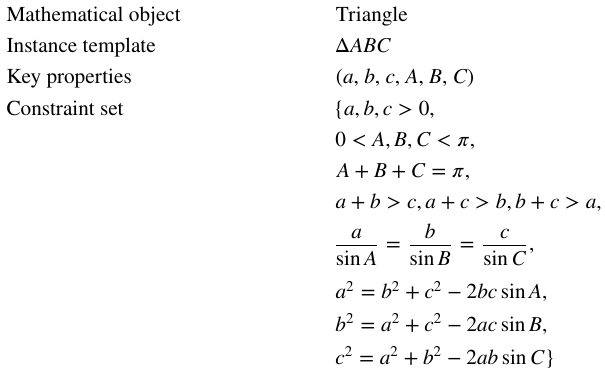
Table 3 An example of object node: